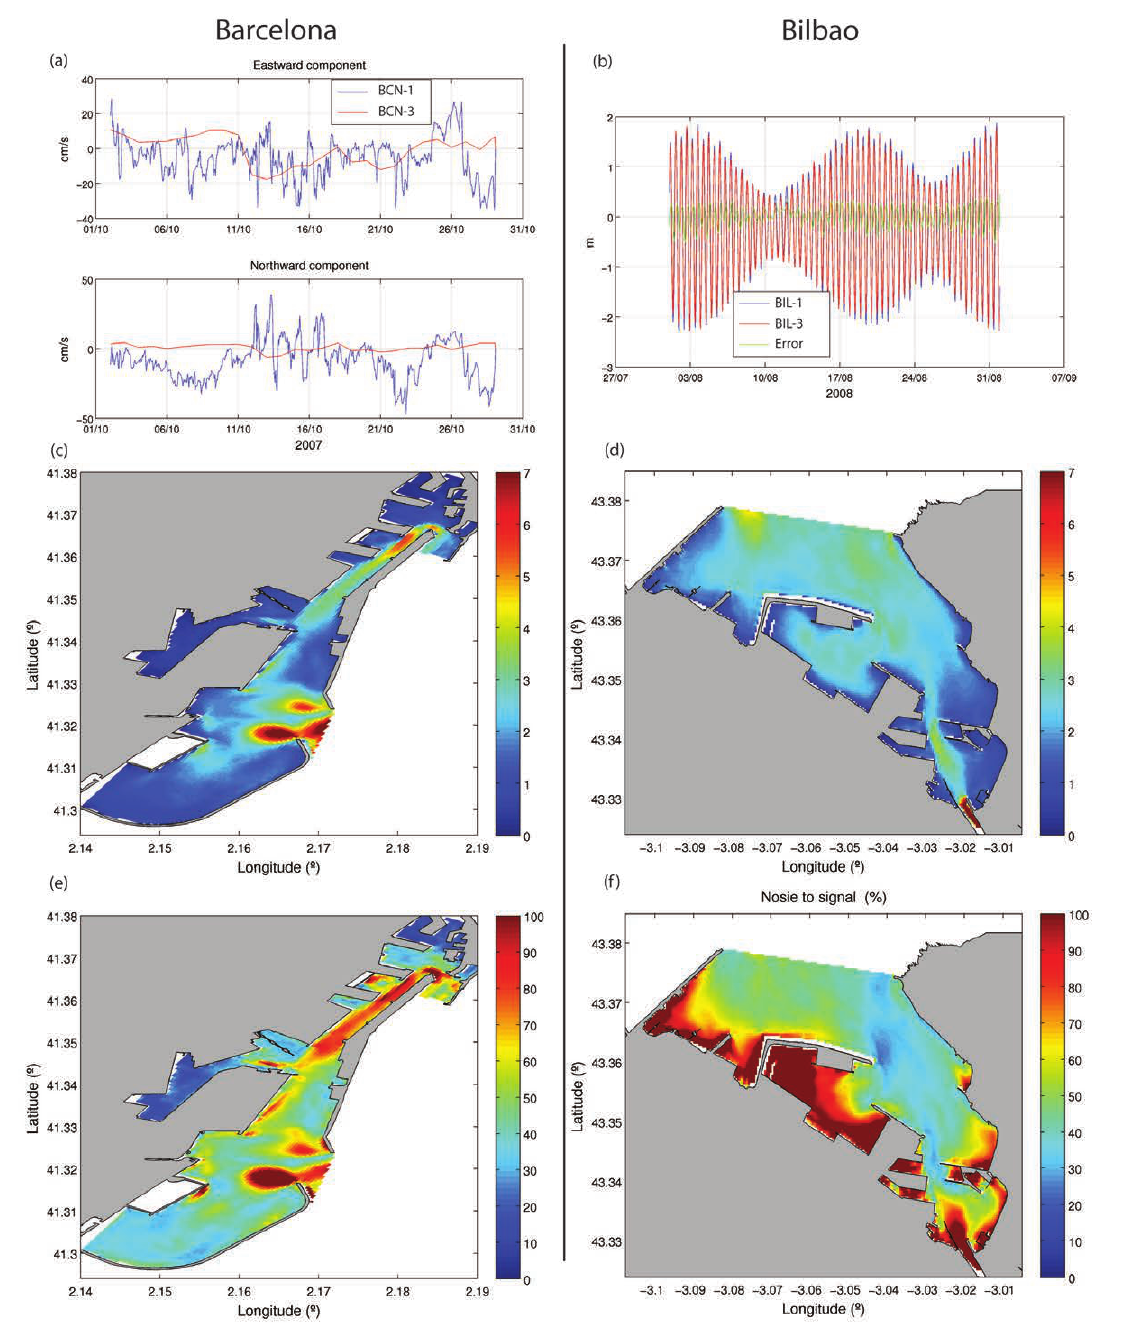
F ig . 8. – Impact of lateral boundary conditions errors in Barcelona (left panel) and Bilbao (right panel) harbours, for October 2007 and August 2008, respectively. (a) Shelf current components (cm s –1 ) from observations (blue line) and provided by the coastal model (red line). (b) Sea level (m) from observations (blue line) and provided by the coastal model (red line). Also, the difference is plotted (green line). (c, d) RMSE (cm s –1 ) obtained with the coastal model results for the lateral boundary conditions. (e, f) NSR (%; see text for details). The results are